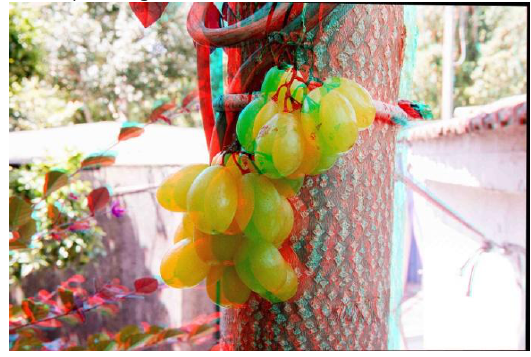
Figure 11. Traditional anaglyph